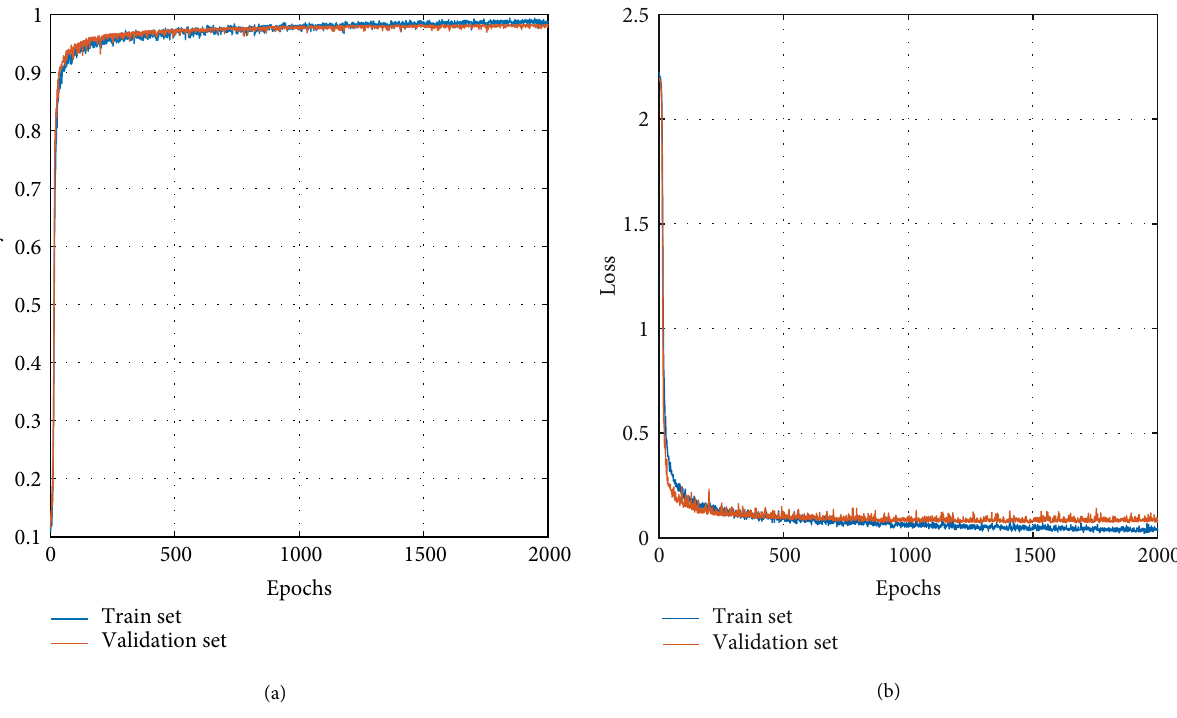
Figure 4: The training process of proposed network.